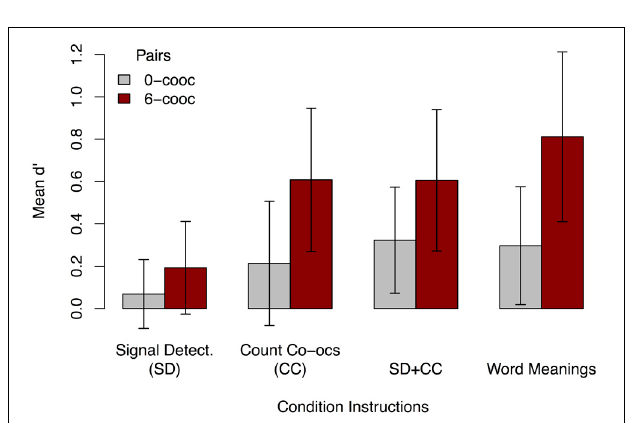
FIGURE 5 | Mean d (cid:2) for 0- and 6-co-occurrence word-object pairings in Experiment 2, by condition. As in Experiment 1, learners were more sensitive to correct (i.e., 6-co-occurrence) pairings than to 0-co-occurrence pairs, although in Experiment 2 they were sensitive to these pairings, except in the signal detection (SD) and count co-occurrences (CC) conditions. The SD condition showed less sensitivity to correct pairings than the other conditions. Error bars show 95%